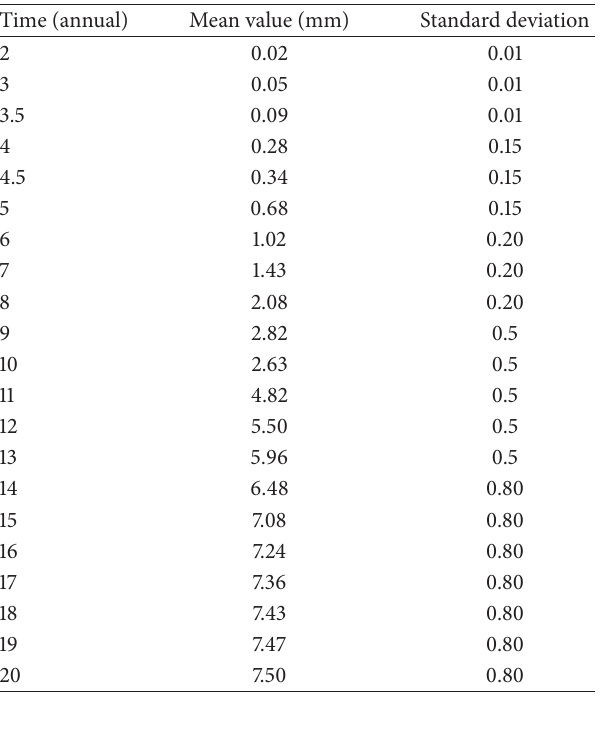
Table 1: Corrosion data.